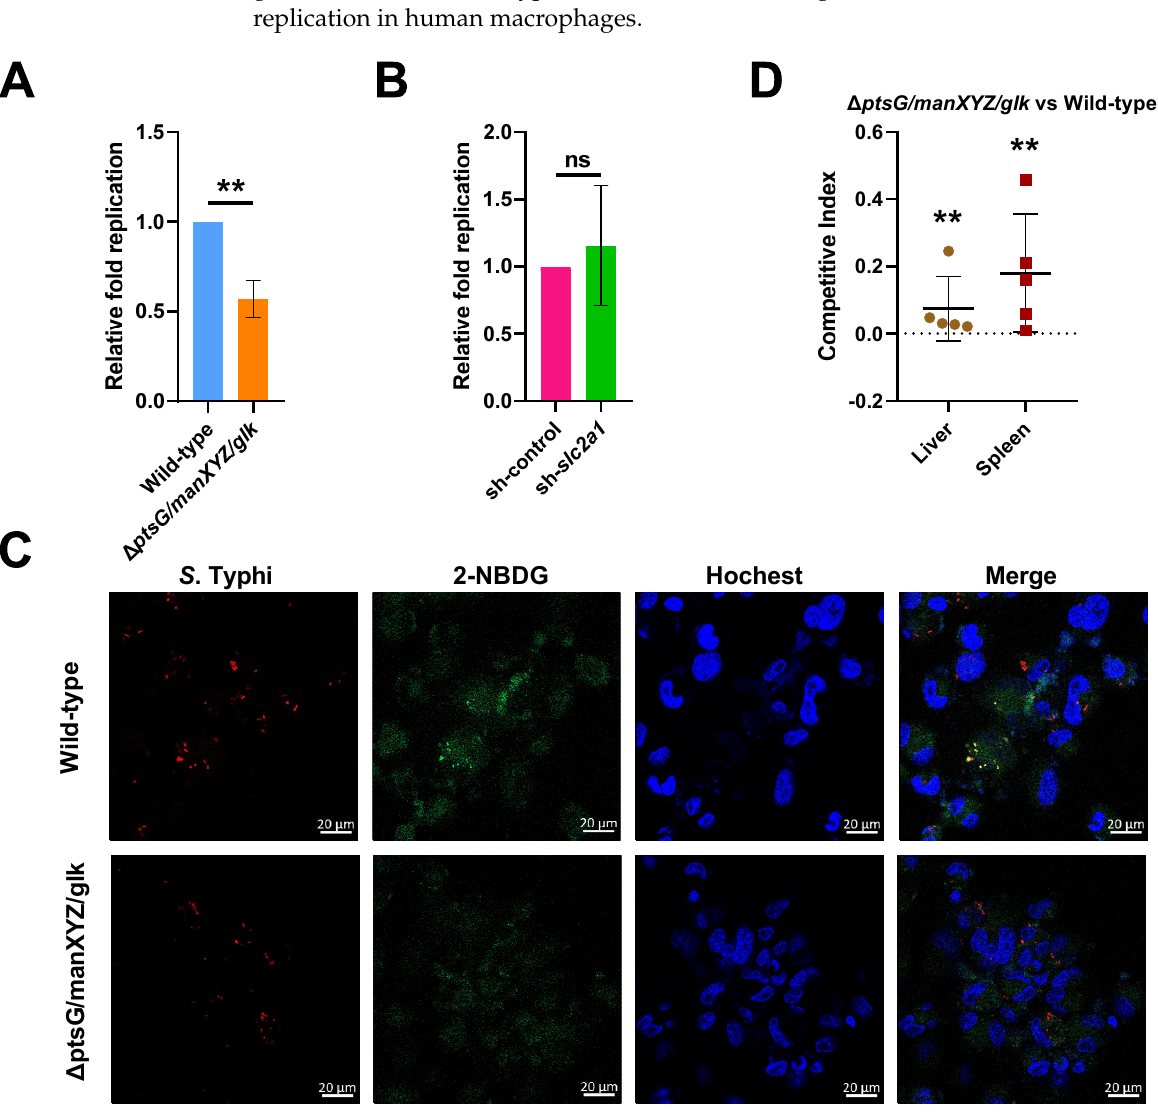
Figure 6. Salmonella enterica serovar Typhi ( S. Typhi) uses host-derived glucose as a nutrient for intracellular replication and systemic infection. ( A ) Replication of wild-type S . Typhi and the ∆ ptsG/manXYZ/glk mutant strain in THP-1 cells, and ( B ) replication of ∆ ptsG/manXYZ/glk in sh- slc2a1 or sh-control THP-1 cells. ( A , B ) The data were obtained from three independent experiments and analyzed using Student’s t -test. ( C ) Representative images showing the distribution of the fluorescent glucose analog, 2-( N -(7-nitrobenz-2-oxa-1,3-diazol-4-yl) amino)-2-deoxyglucose (2-NBDG) distribution in wild-type or Δ ptsG/manXYZ/glk -infected THP-1 cells. Red, bacteria; green, 2-NBDG; blue, nuclei. Scale bars represent 20 μ m. The images are representative of three independent experiments. ( D ) Competitive index of Δ ptsG/manXYZ/glk vs. the wild-type in the liver and spleen of humanized mice. The data from two independent experiments were combined and analyzed using the Mann–Whitney U-test based on colony-forming unit counts of Δ ptsG/manXYZ/glk vs. wild-type. ** p < 0.01; ns, not significant .